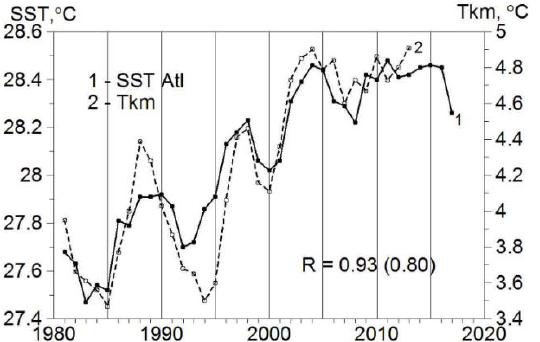
Figure 3. Anomalies of SST in the low latitudes of the North Atlantic in October (1) and water temperature in the 50 – 200 m layer at the section along the Kola meridian in the Barents Sea in De- cember – February (2). The series is smoothed with a 3-year window and normalized. The lag (27 months) between the series is taken into account. R — correlation coefficient between series (1) and (2). In brackets — between no smoothed series.